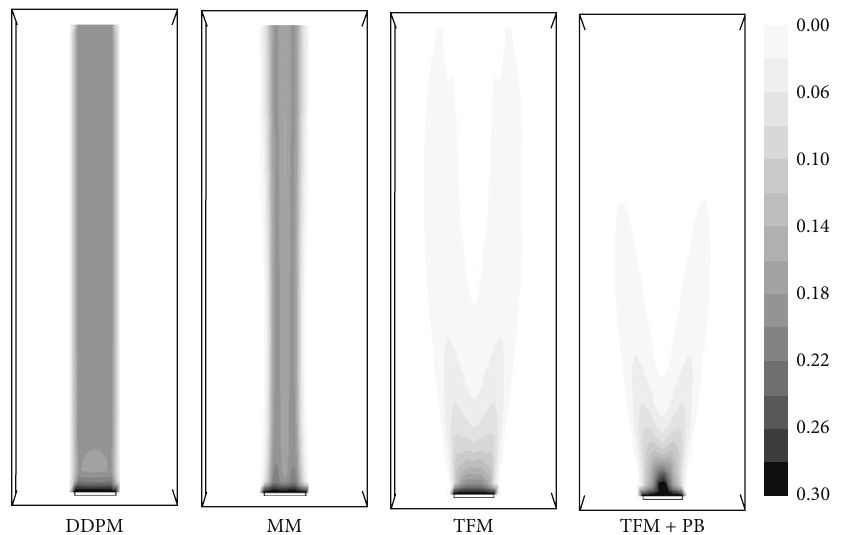
Figure 3: Contours of the bubble volume fraction predicted by the different models along an axial midplane in the reactor.